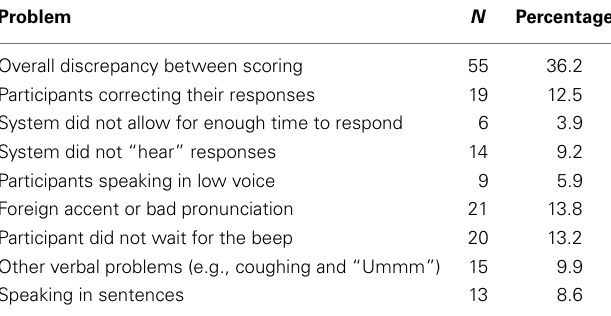
Table 3 | Issues causing verbal recognition problems by the system (Digit Span Forward task).